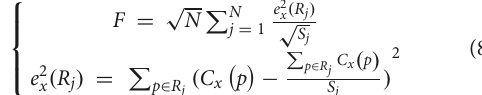
TABLE 1 Implementation of pseudocode in MATLAB language on merging the clusters that contain a certain number of superpixels.